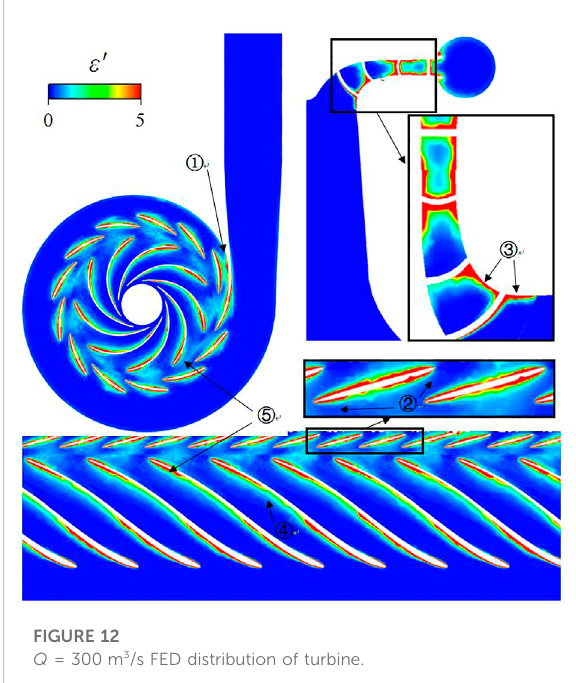
FIGURE 11 Q = 300 m 3 /s FED distribution of pump.